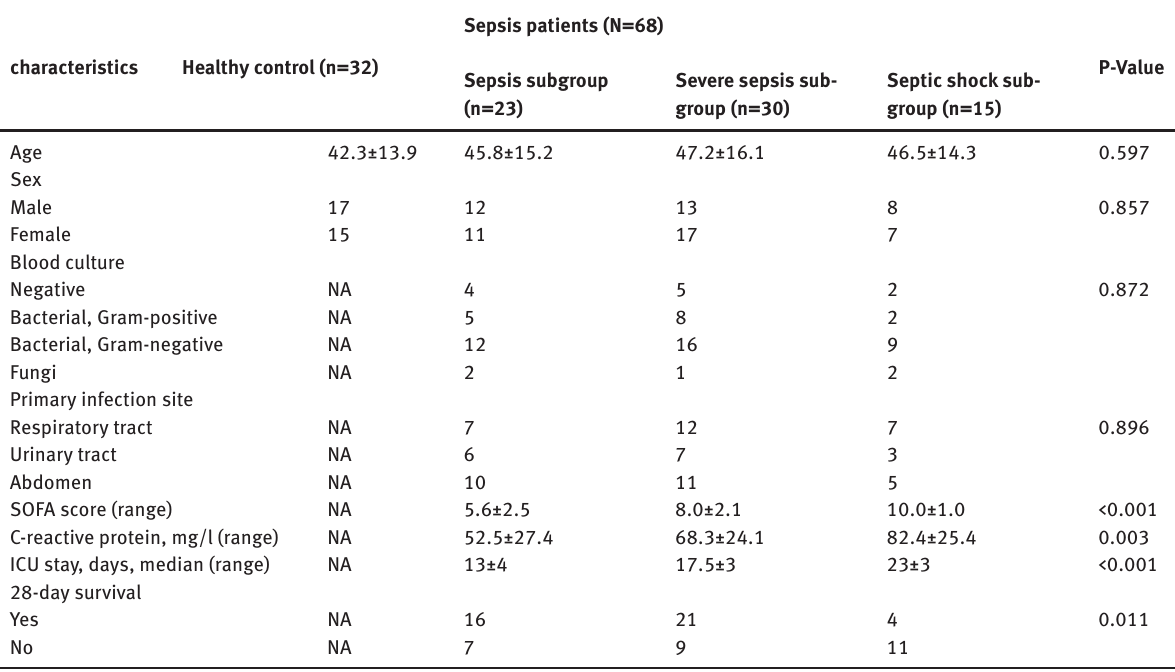
Table 1: Clinical characteristics of the patients in this study.